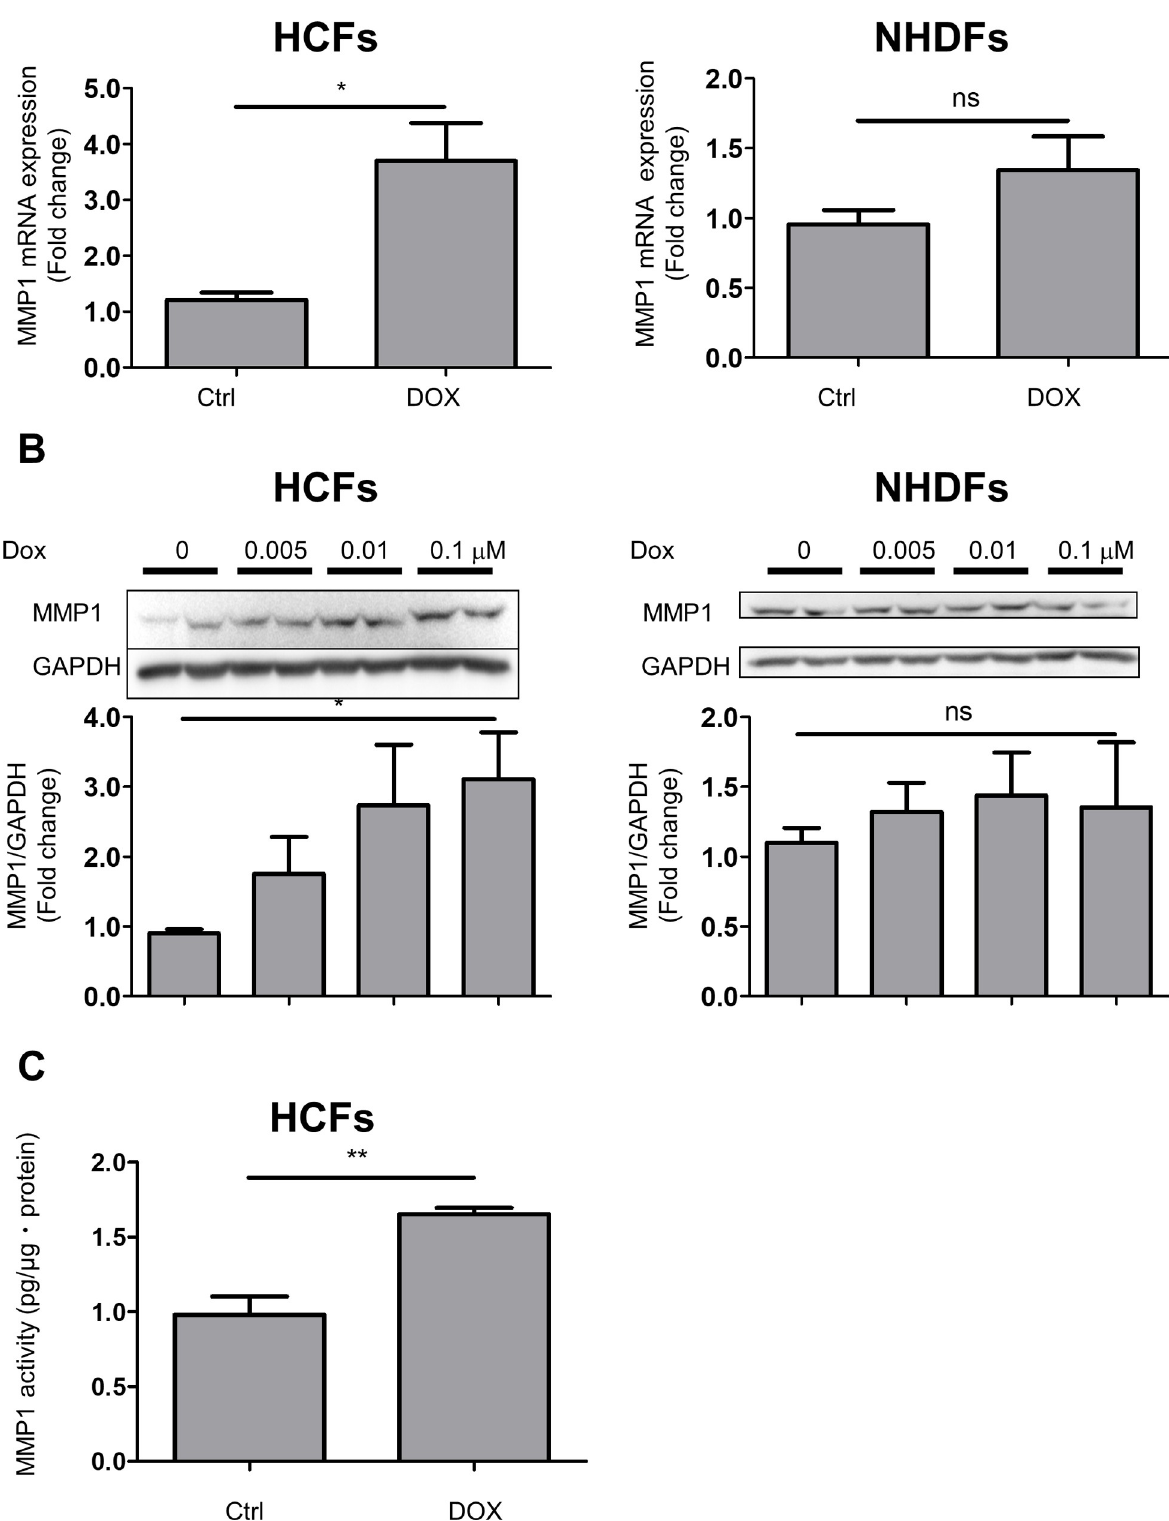
Fig 3. DOX induced MMP1 expression and production in HCFs but not in NHDFs. A, MMP1 mRNA expression in the presence of DOX (0.1 μ M) for 24 hours in HCFs (left) and NHDFs (right) (n = 4–5; � p < 0.05; ns: no significant difference). B, MMP1 protein expression in HCFs (left) and NHDFs (right) stimulated by DOX (0.1 μ M) for 48 hours (n = 4–6; � p < 0.05; ns: no significant difference). The original immunoblot image is shown in S2B Fig. C, Activity of MMP1 in supernatant from HCFs exposed to DOX (0.1 μ M) for 48 hours (n = 4; �� p < 0.01).